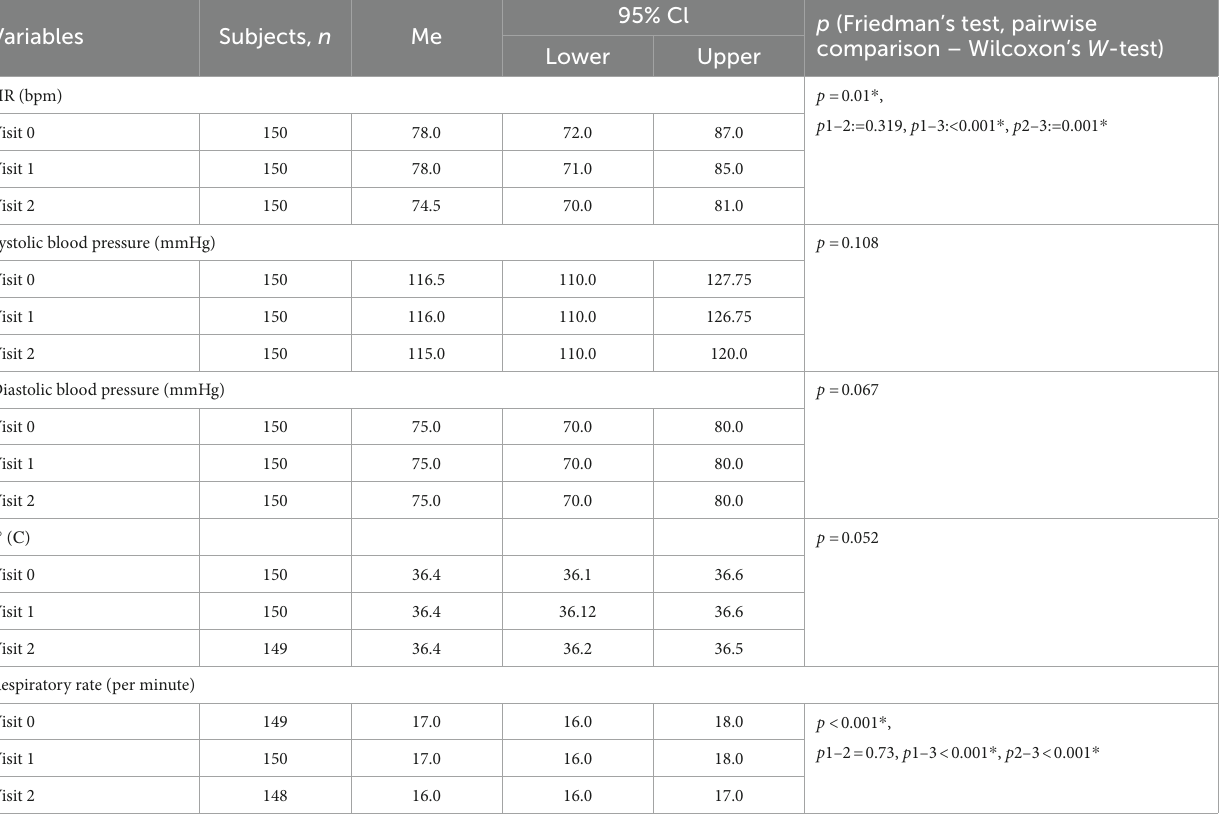
TABLE 3 Dynamics of parameters over